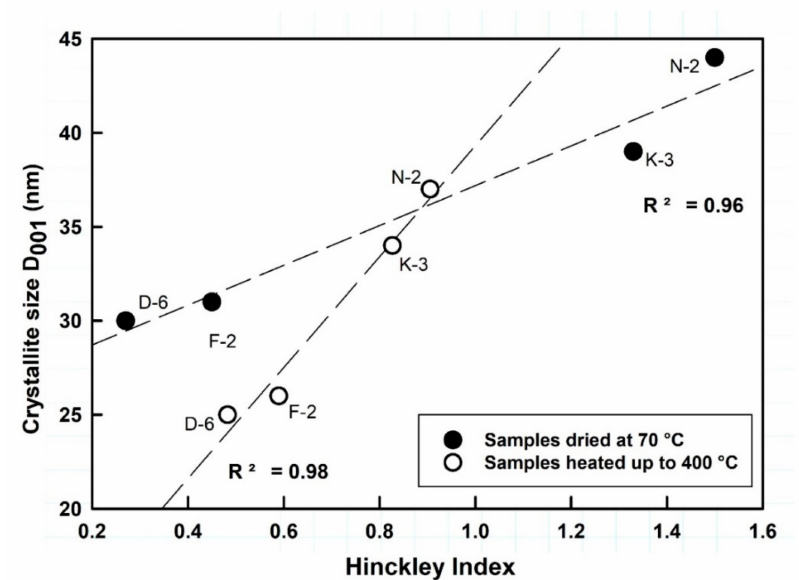
Figure 3. Relationship between kaolinite structural characteristics with observed shifting upon thermal